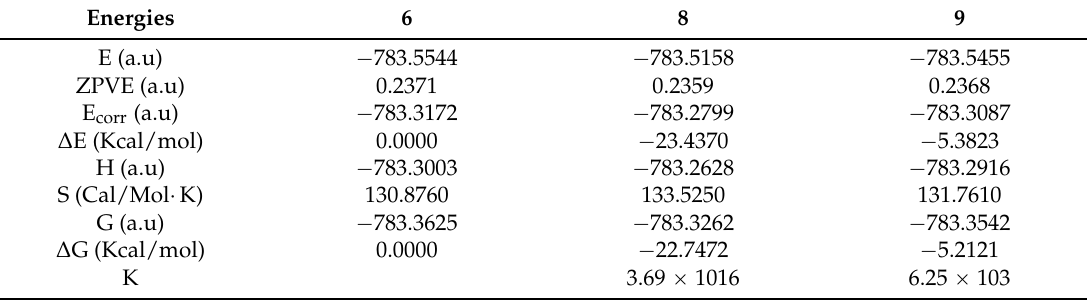
Table 4. The energies, thermodynamic parameters and rate constants (k) of the studied reactants. Energies